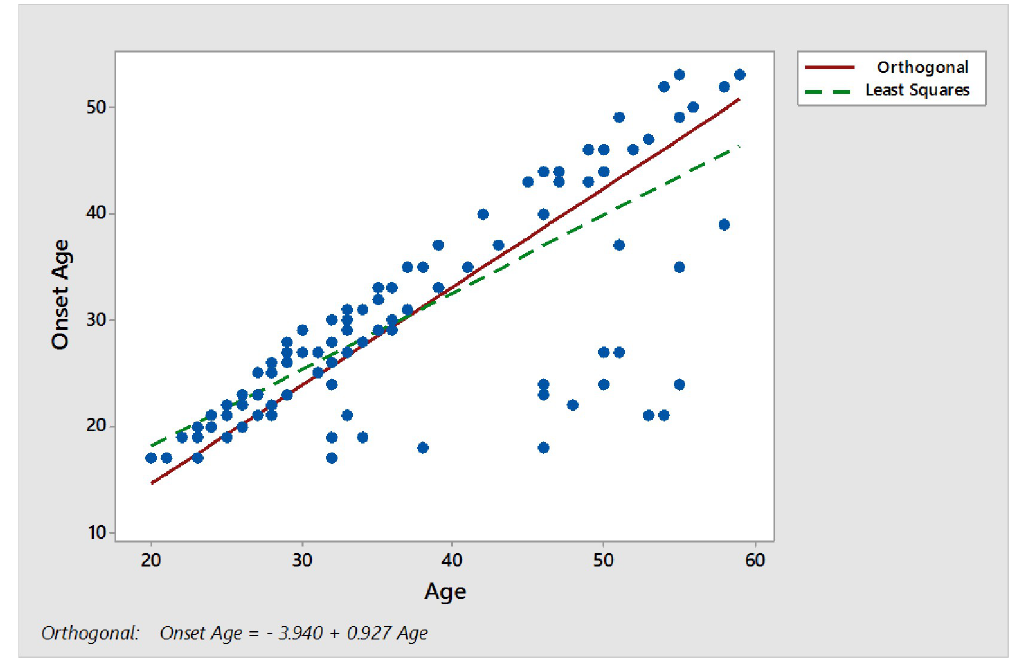
Fig 3. Age of onset of sleep